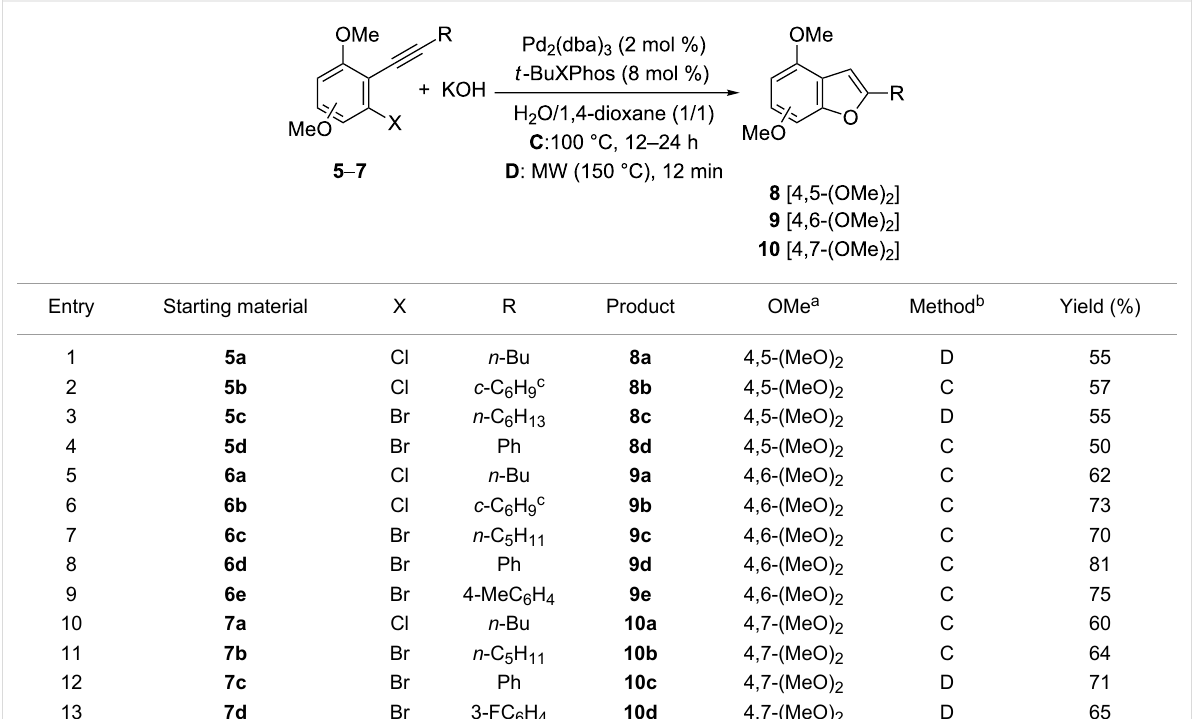
Table 3: Synthesis of dimethoxy-substituted benzo[ b ]furans 8 – 10